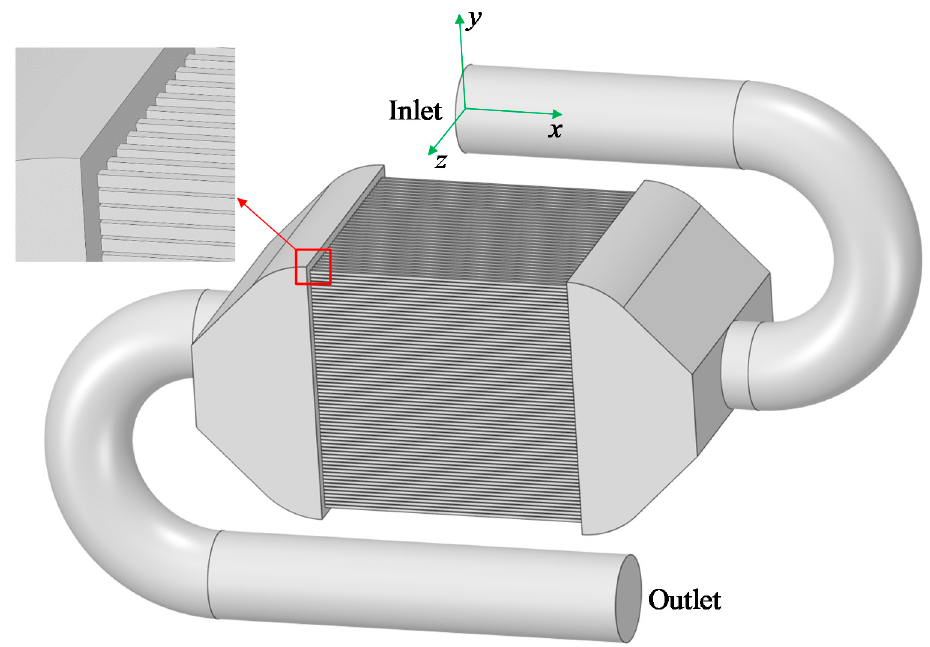
Figure 2. One-quarter (1/4)-scaled geometry model for the sodium flow side.